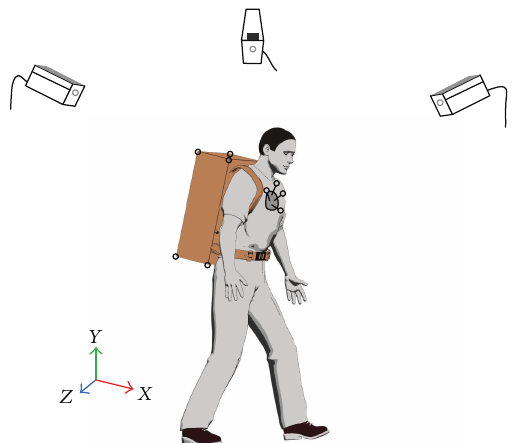
Figure 5: The 3D gait measurement setup for capturing the trunk and pack motions during load carriage. A specially designed plastic plate carrying four markers, firmly attached to the thorax, was used to capture the position and orientation of the trunk. Eight markers were attached to the corners of the pack to capture its position and